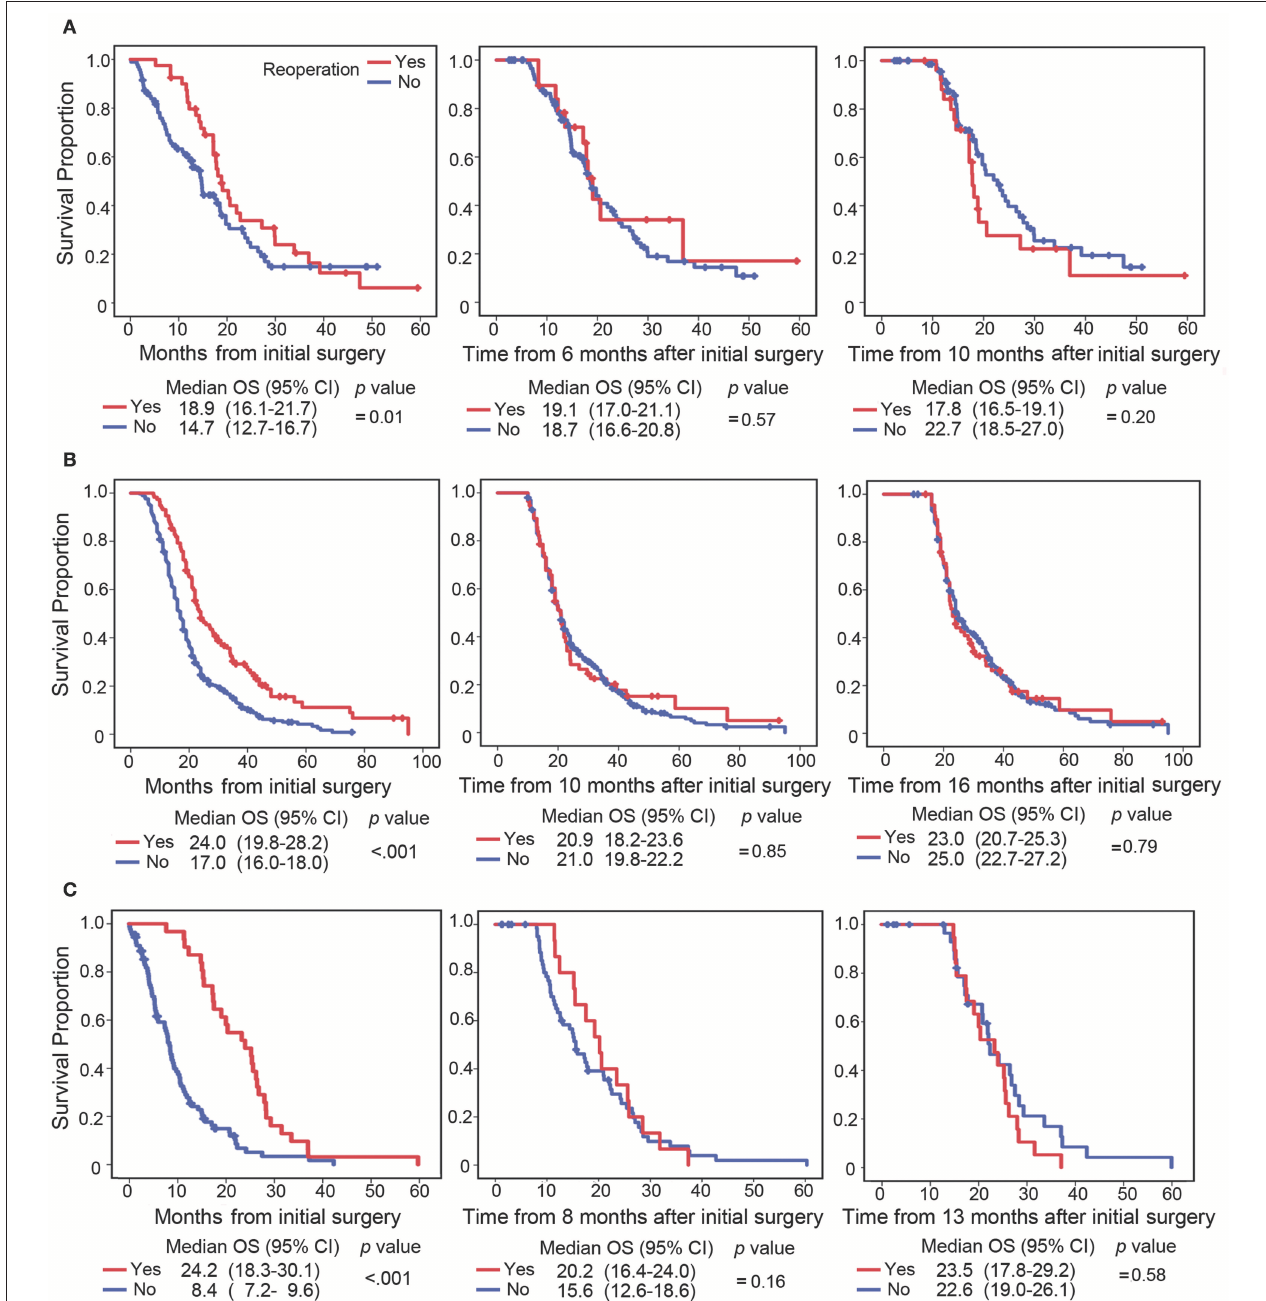
FIGURE 3 | Survival curve plotted by the Kaplan-Meier and landmark methods. The survival data from the studies of Woernle et al. (25) (A) , Zanello et al. (15) (B) , and Delgado-Fernandez et al. (12) (C) were reanalyzed by the Kaplan-Meier (left) and landmark methods (middle and right). The Kaplan-Meier curve started at the initial diagnosis (left), and the landmark curve started at the 50th percentile (middle) and 75th percentile (right) of time between first and second surgery. In the landmark method, patients were considered to have reoperation if their reoperation occurred by the landmark time and were considered to not have reoperation if they did not undergo reoperation or their reoperation occurred after the landmark time.